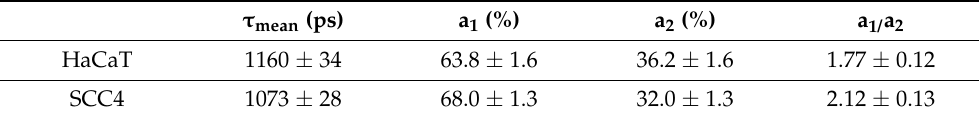
Table 3. Mean fluorescence lifetime ( τ mean ) and associated exponential coefficients (a i ) of NAD(P)H in HaCaT and SCC4 cells. The values were calculated by a two-exponential fit decay analysis performed with the fixed lifetimes τ 1 = 400 ps and τ 2 = 2.5 ns.